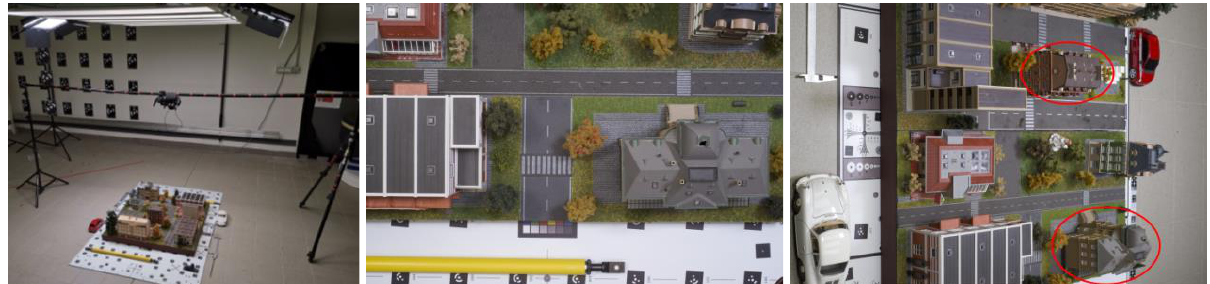
Figure 1. The test-object and acquisition scenario adopted for the 3DOMcity photogrammetric contest: setup for data collection (left) and examples of nadir (centre) and oblique (right) images. Red ellipses highlight the buildings selected for DIM